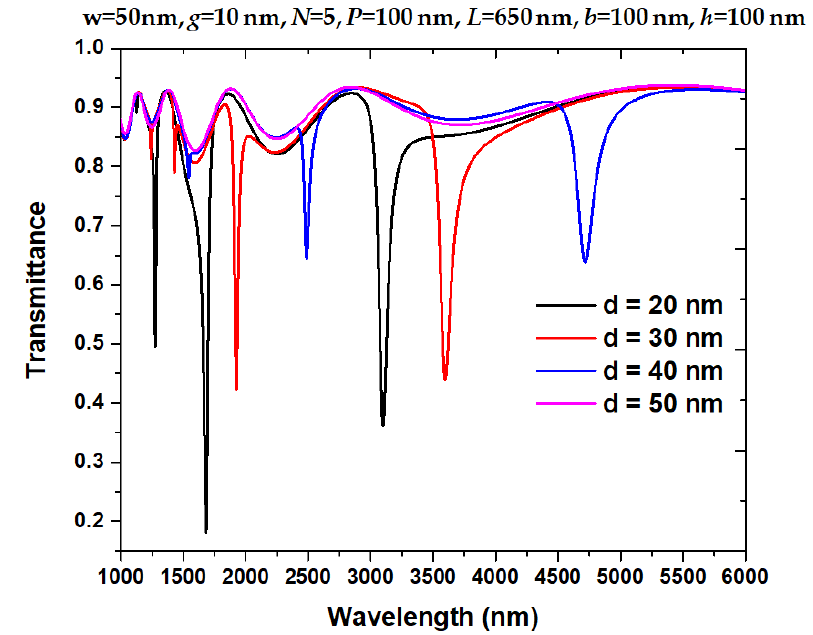
Figure 6. Transmittance spectrum of the proposed structure when deformation d = 20 nm, 30 nm, 40 nm, and 50 nm, respectively. Table 2. Comparison of (∆λ res (nm), S(nm/MPa)) of the designed structure for b = 50, 100, 150, and 200 nm .